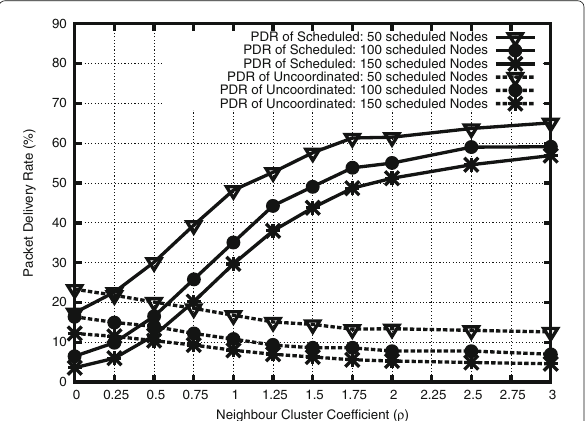
Fig. 9 Network goodput with CA and DUD algorithms, for K = 100, M = 100, and CCA thr = − 90 dBm